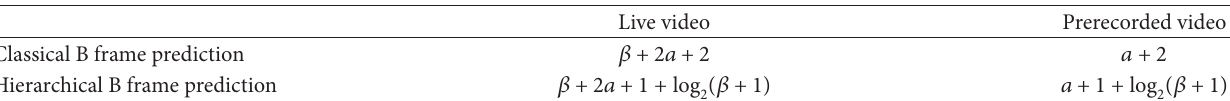
Table 2: End-to-end delay in frame periods for video encodings with 𝛽, 𝛽 ≥ 1 , B frames between successive I/P frames and smoothing over a frames from [17]; encoding, network transport, and decoding are assumed to each requiring one frame period per